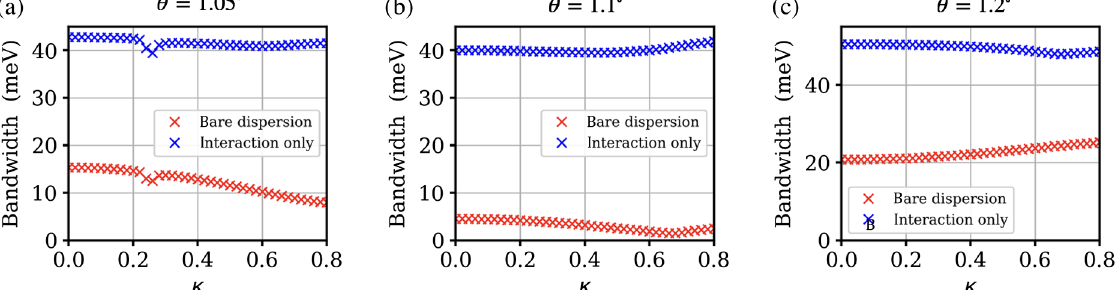
ˆ H θ ¼ 1 . 05 °, 0 and the interaction-only model at (a) = ð 3 a 0 = 2 Þ(cid:3) ¼ 2700 meV, w 0 ¼ 105 meV, f Þ